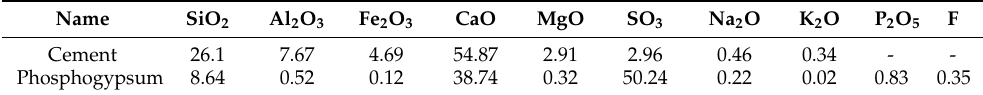
Table 1. Chemical composition of cement and phosphogypsum (wt.%).